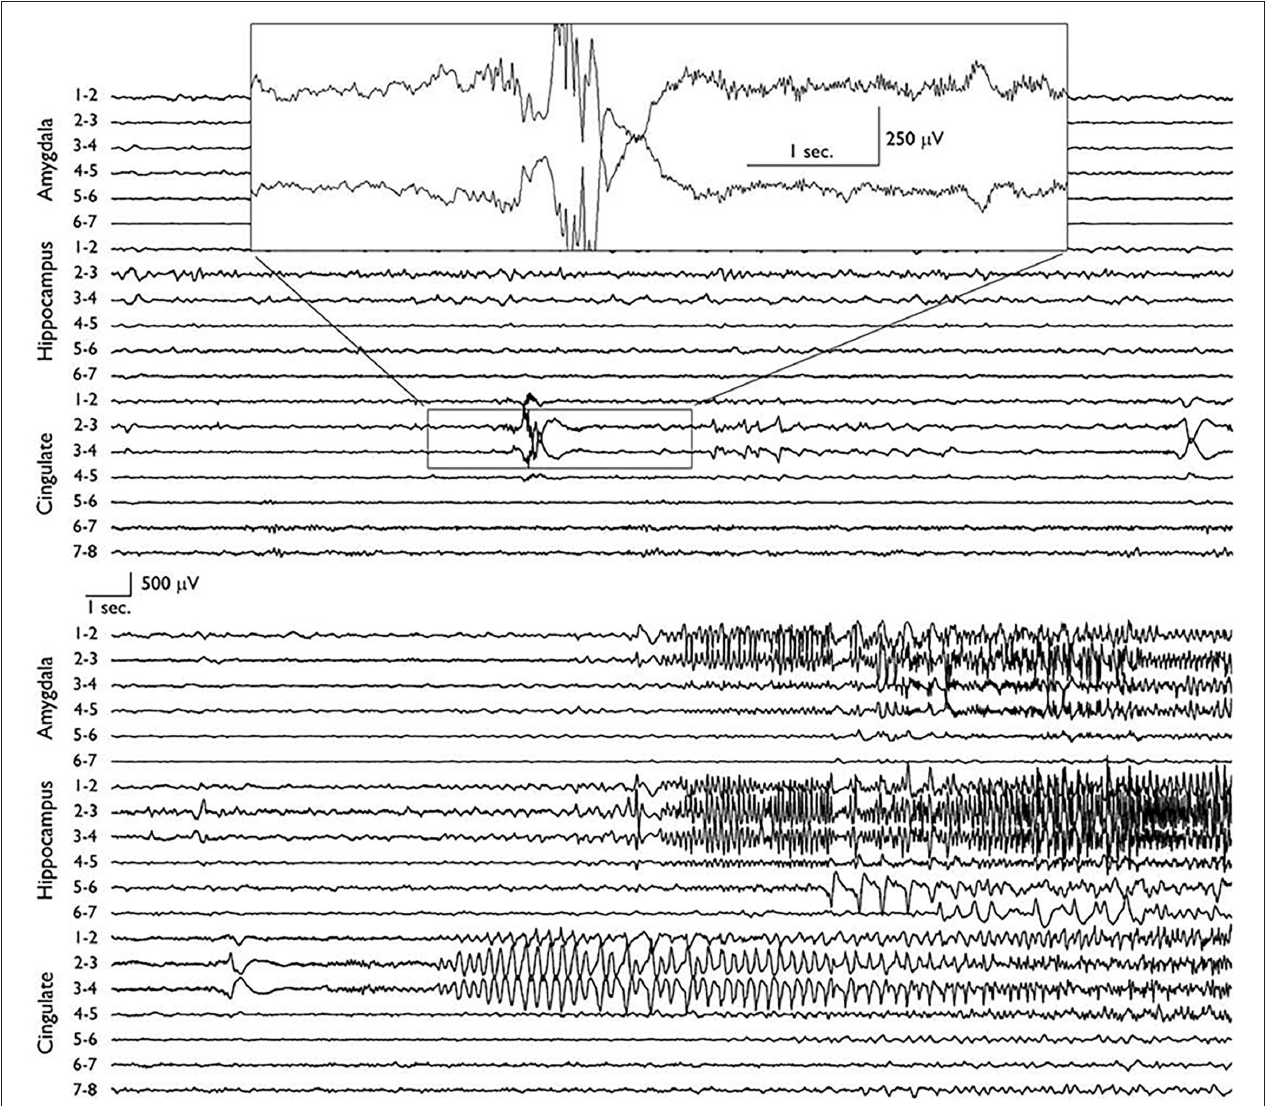
FIGURE 3 | Depth electrode recordings of two consecutive EEG pages showing the ictal onset in the posterior cingulate area before later propagation to the ipsilateral mesial temporal structures. The seizure was semiologically silent before it involved the hippocampus and amygdala